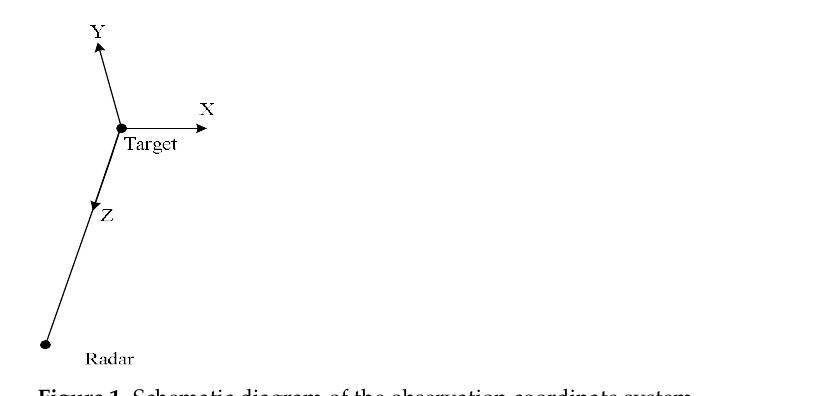
Figure 1. Schematic diagram of the observation coordinate system.